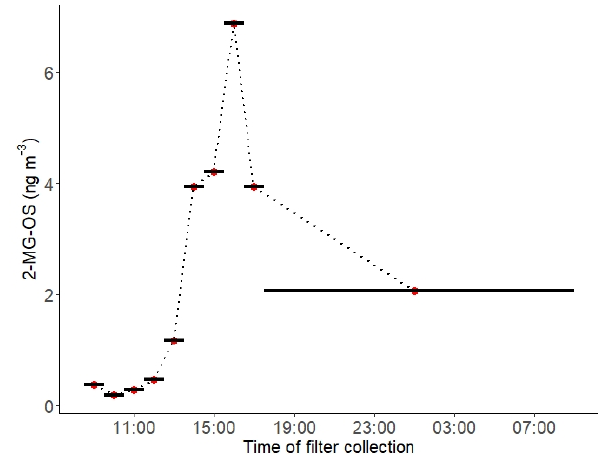
Figure 8. Diurnal profile of 2-methylglyceric acid sulfate (2-MG- OS) in particulate matter collected on filters hourly from 11 to 12 June 2017. The black lines indicate length of the sampling peri- ods.